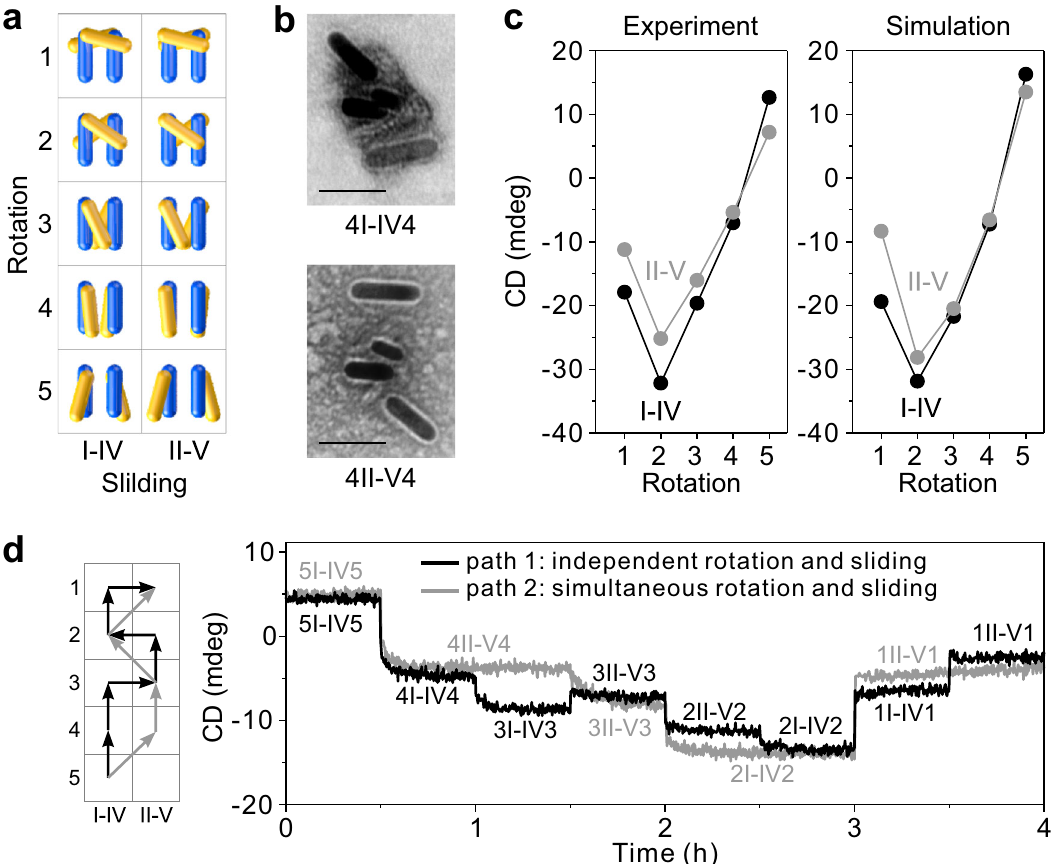
Fig. 4 Optical characterizations of the DIMERs. a 10 states of the DIMER with 5 rotation positions and 2 sliding positions. b Representative TEM images of the DIMERs at states 4I-IV4 and 4II-V4, respectively. Scale bar: 50 nm. c Experimental and simulated CD results of the DIMERs extracted at 721 nm at these 10 states. The concentration of the AuNRs in each sample is about 0.2 nM. d Time-course measurements of the DIMERs transitioning among different states, following independent (path 1, black) and simultaneous (path 2, gray) rotation and sliding. The concentrations of the AuNRs in the two samples are about 0.1